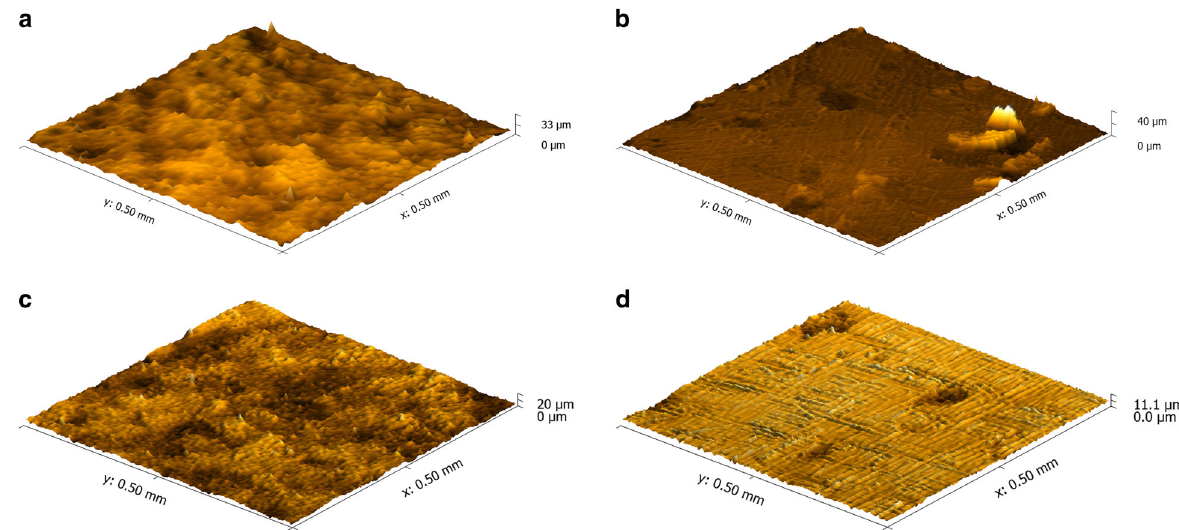
Fig. 4 Three-dimensional surface images corresponding to the experimental groups: a group C, b group CG, c group E, d group